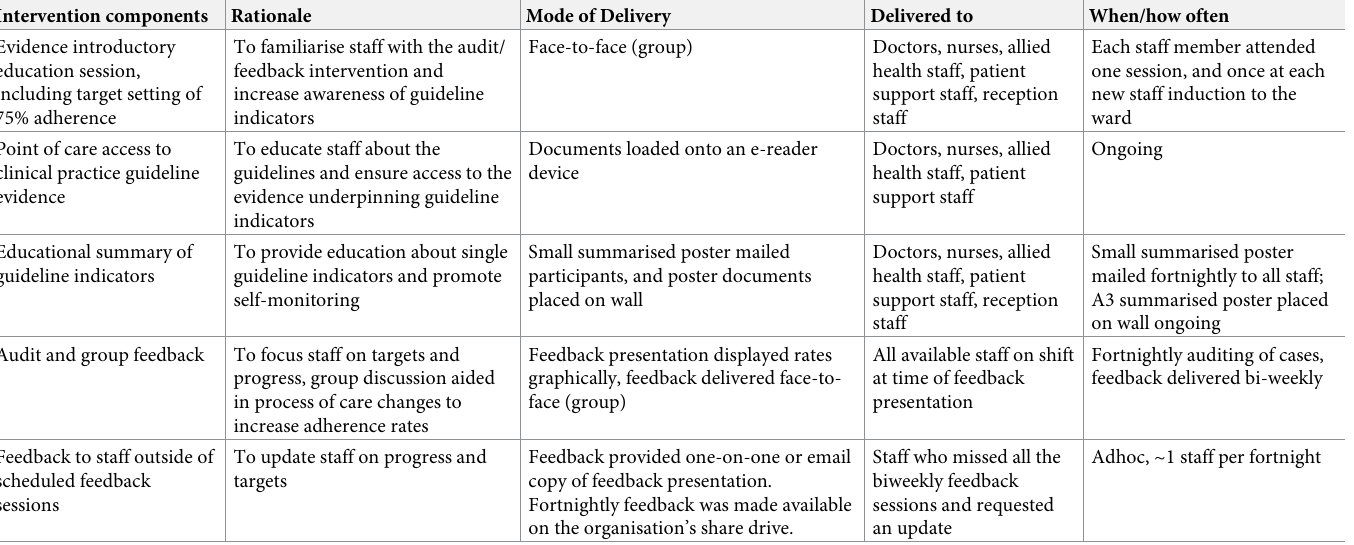
Table 2. Intervention summary based on TIDieR, delivered by